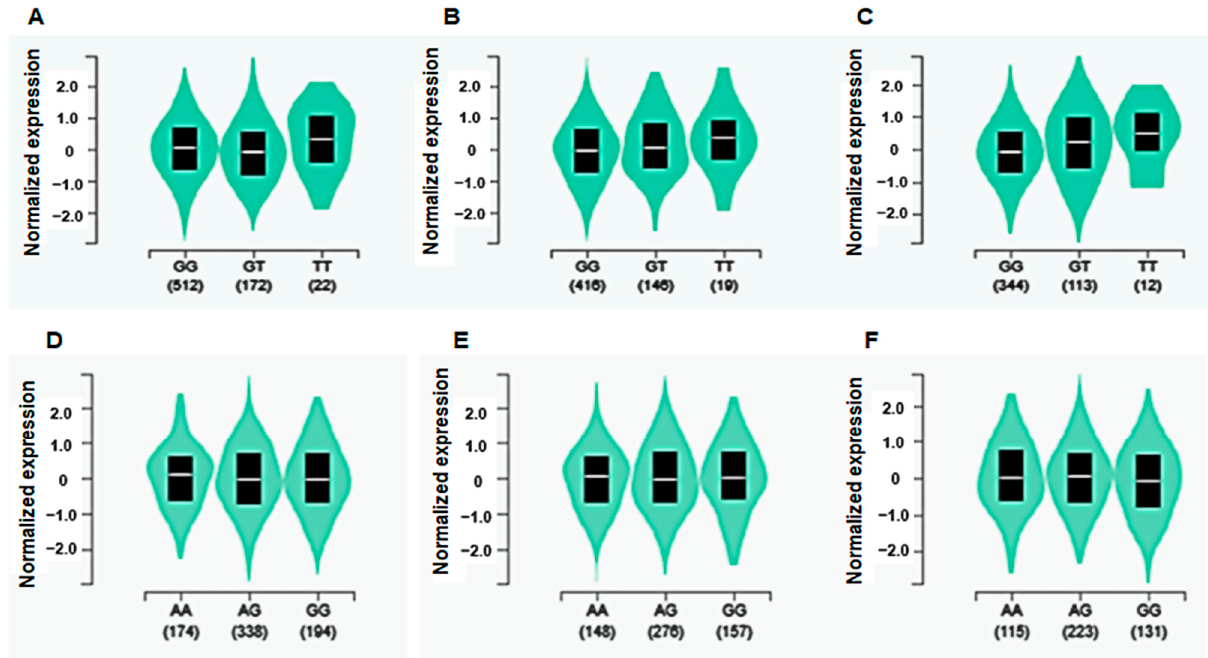
Figure 2. Gene expression of COX10 _rs62054459 and AIG1 _rs6570550 in the skeletal muscle, subcu- taneous and visceral adipose tissue by eQTL analysis. Gene expression of the genetic variants to influence OA risk was identified by eQTL analysis in the Genotype-Tissue Expression (GTE) × eQTL calculator. ( A ). COX10 _rs62054459 in the skeletal muscle ( p = 0.47); ( B ). COX10 _rs62054459 in sub- cutaneous adipose tissue ( p = 0.015); ( C ). COX10 _rs62054459 in visceral adipose tissue ( p = 0.014);